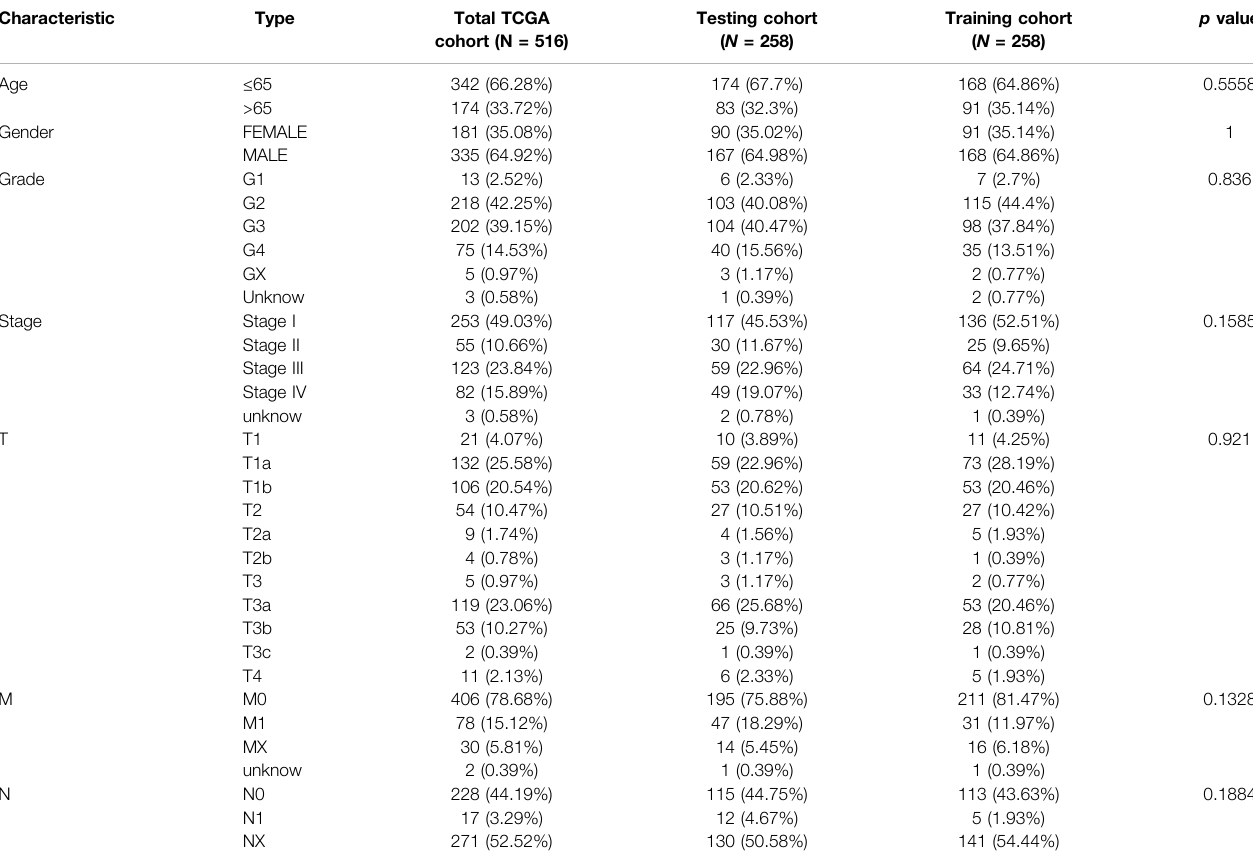
TABLE 1 | Clinicopathological characteristics of 516 ccRCC patients in TCGA-KIRC cohort.